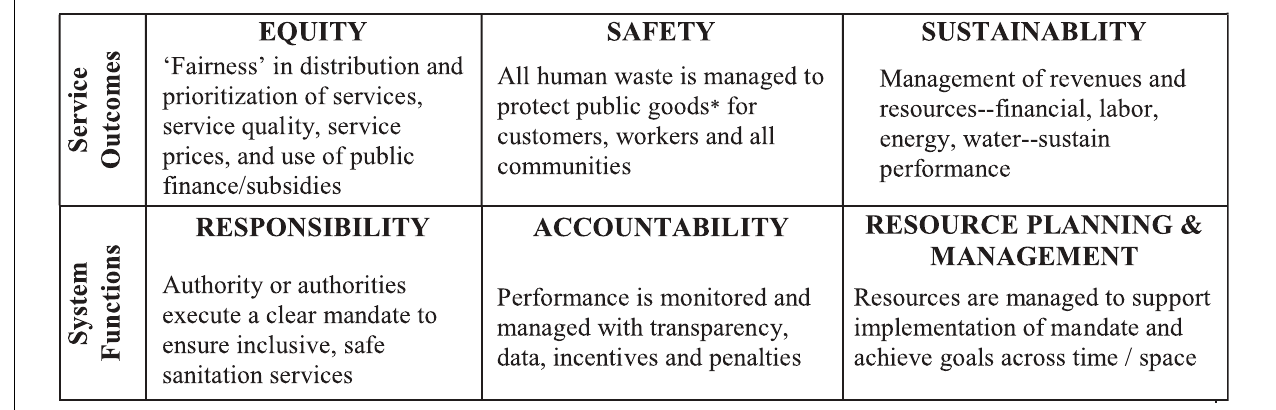
FIGURE 2 | CWIS service framework. *Public Goods are the elements of sanitation service delivery system characterized by market failures –technically, non-excludability and non-rivalry. Practically, they are the elements of sanitation service that are outside of individuals’ direct private interests and can include safe on-site containment, network connections, transporting waste to safe disposal, and other activities required for long-term protection of water, land and public health along the value